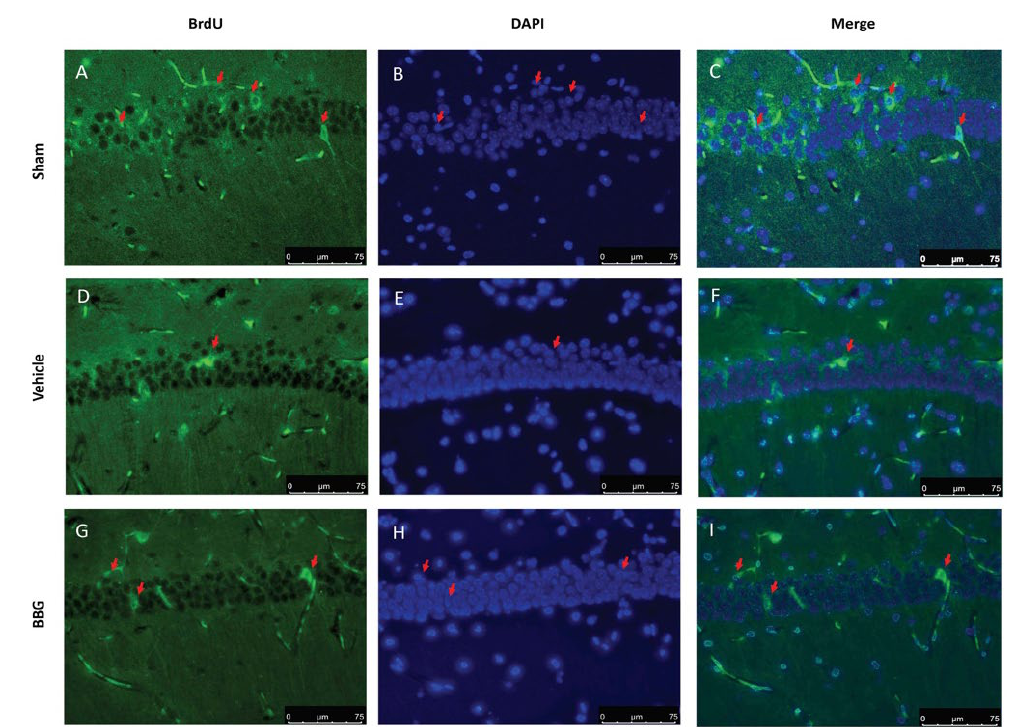
Figure 7. Immunofluorescence evaluation for BrdU expression: sham ( A – C ), vehicle ( D – F ), BBG ( G – I ). The red arrows indicate co-localization of positive cells. Data are representative of at least three independent experiments and are expressed as mean ± SEM from N = 6 rats/group.